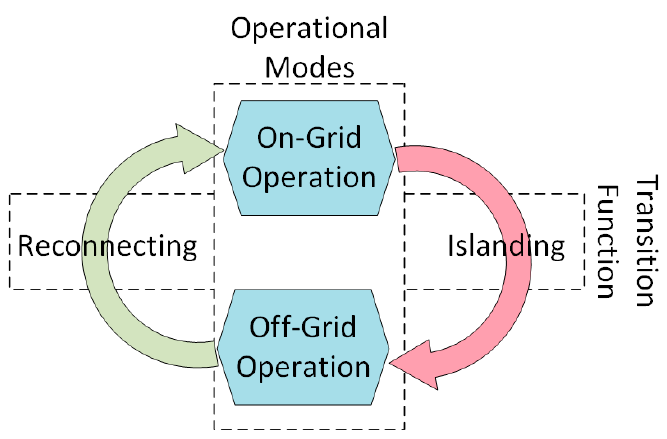
Figure 5. The interaction between operational modes and their transition